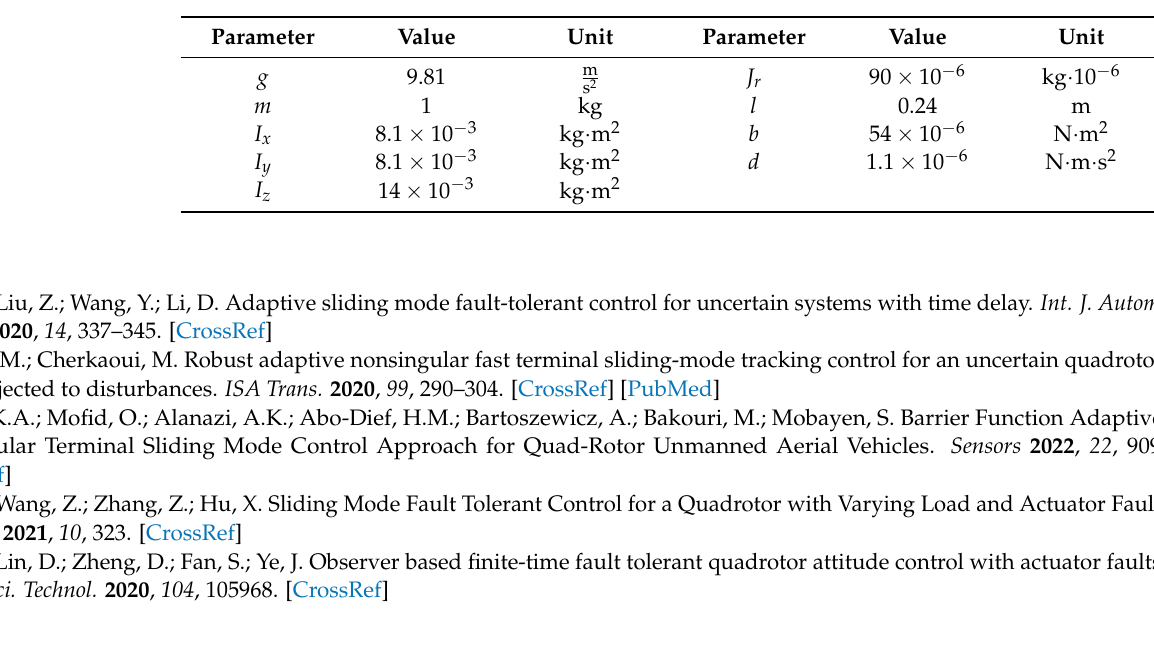
Table A1. Quadrotor parameters